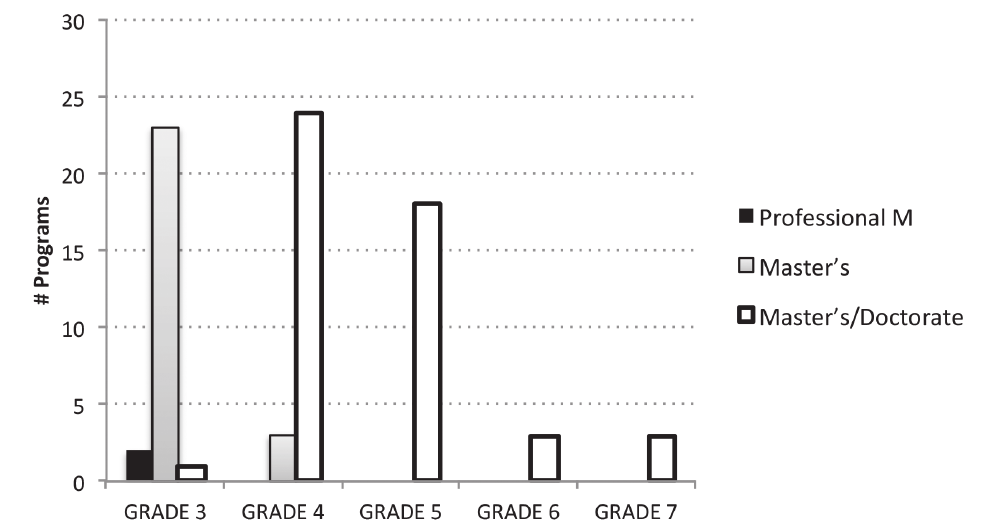
Figure 4. Number of Brazilian psychology postgraduate programs by grade in CAPES, in